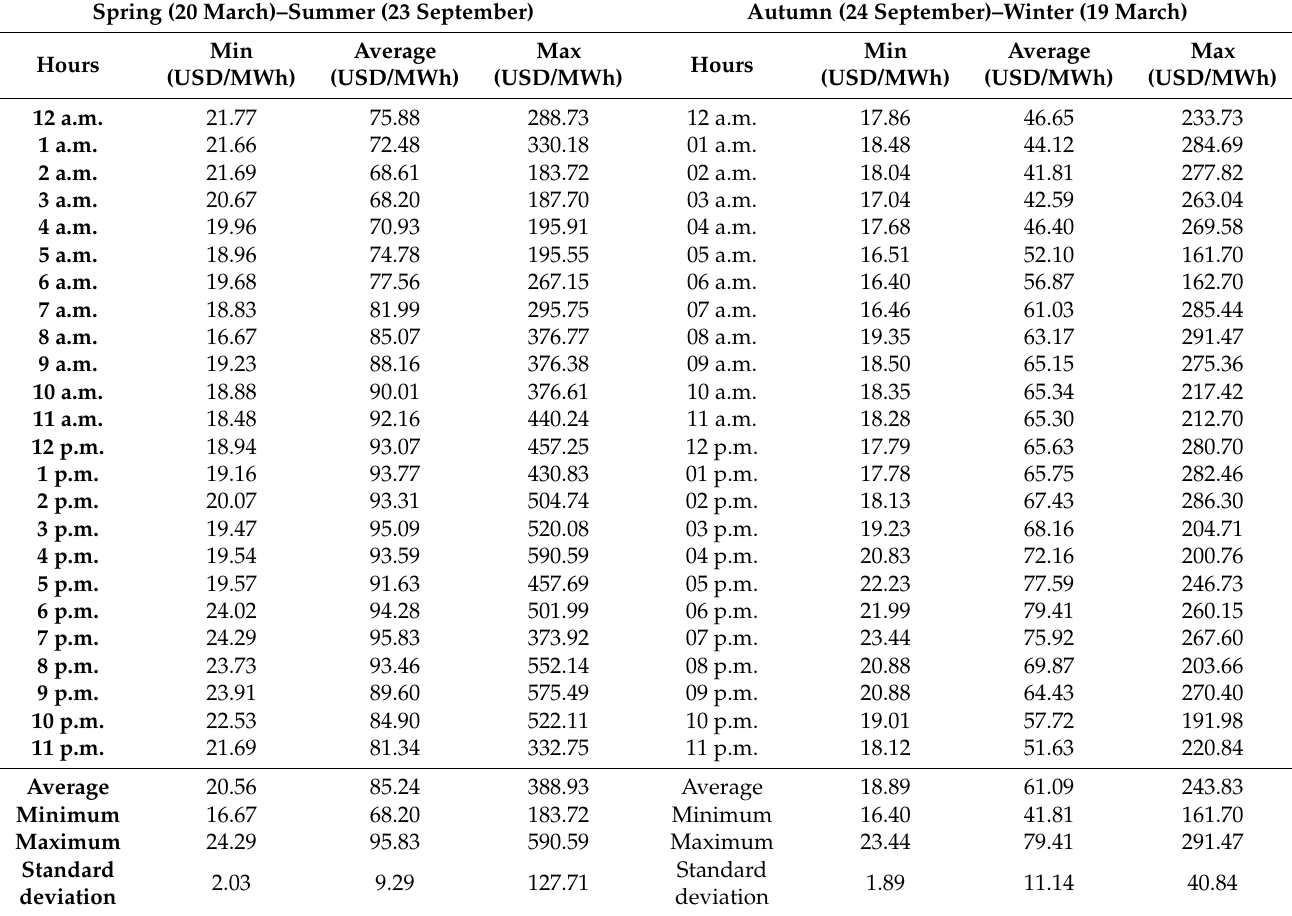
Table 7. Parameters of the local marginal price node 03ZMN-115.